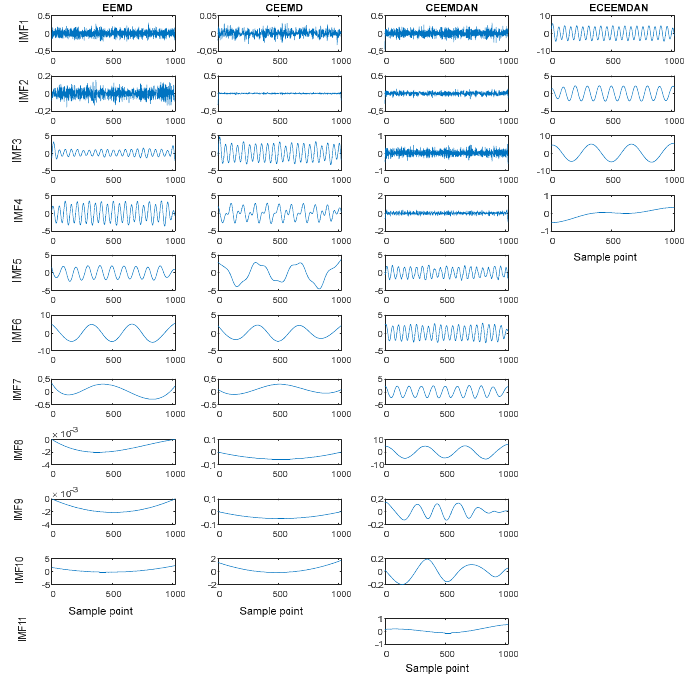
Figure 4. Comparison of decomposing effects of empirical mode decomposition (EMD) improved versions with ECEEMDAN.